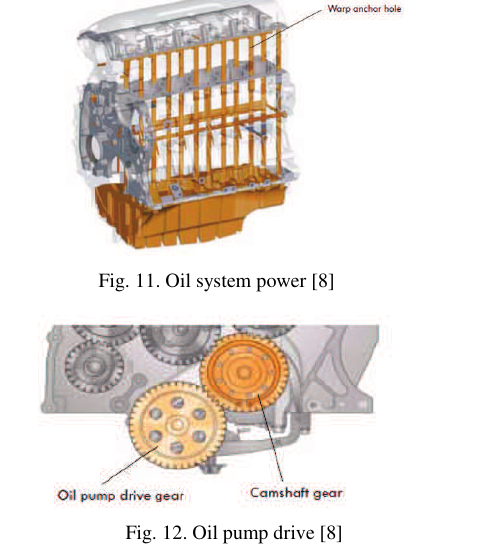
Fig. 12. Oil pump drive [8]